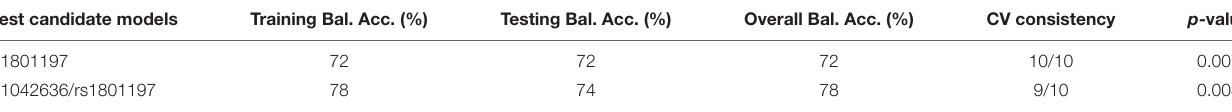
TABLE 4 | Interaction analysis of SNPs in CASR and CALCR and risk of KSD development. Best candidate